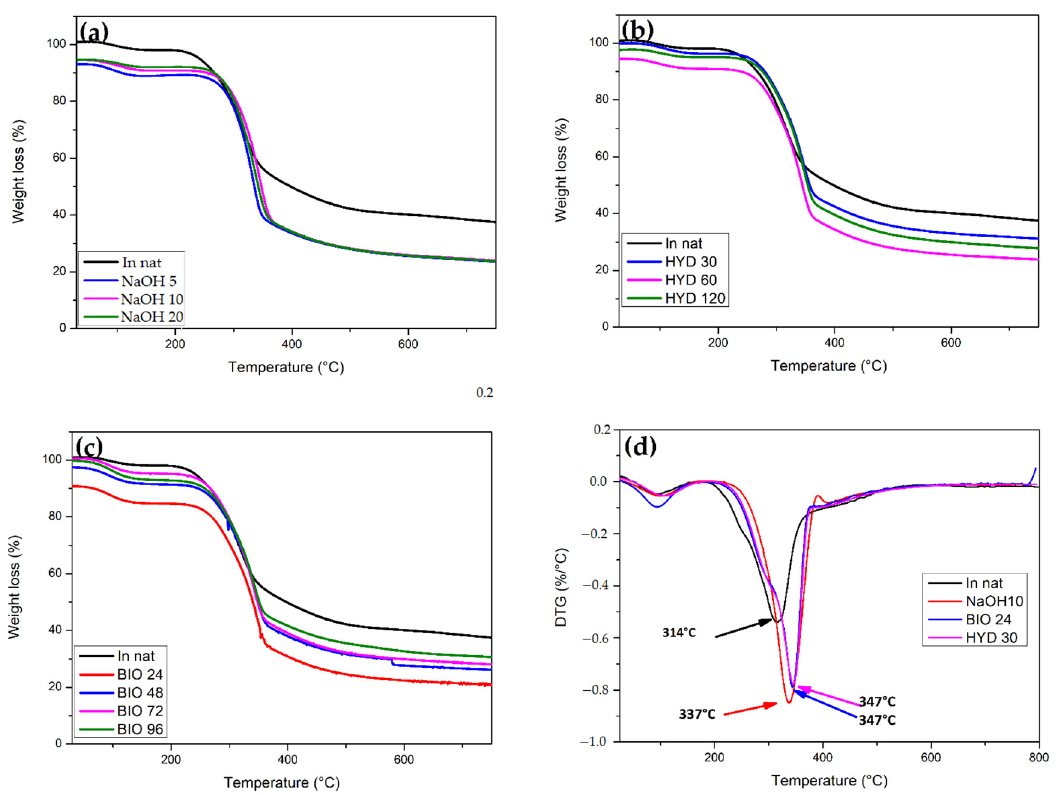
Figure 9. ( a ) TGA NaOH, ( b ) TGA HYD, ( c ) TGA BIO, and ( d ) DTG for fresh CHFW, in natura, as well as subject to NaOH, HYD, and BIO treatment.